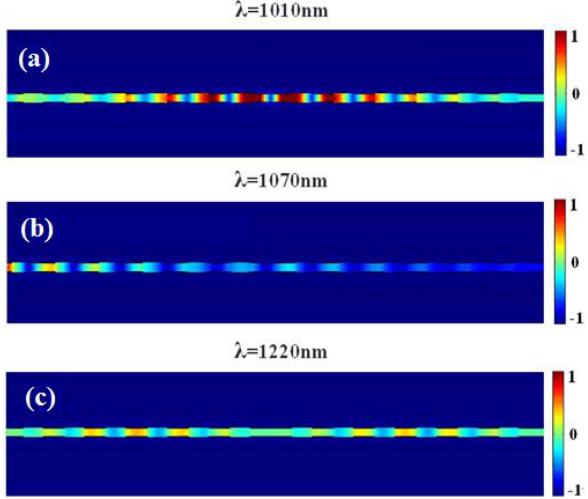
Figure 9. The contour profiles of normalized electric field distributions under different wavelength with defect length d = 200 nm ( a ) λ = 1010 nm; ( b ) λ = 1070 nm; ( c ) λ = 1220 nm.